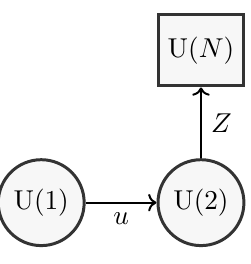
Figure 1 . Quiver diagram for F ( N; 2 ;